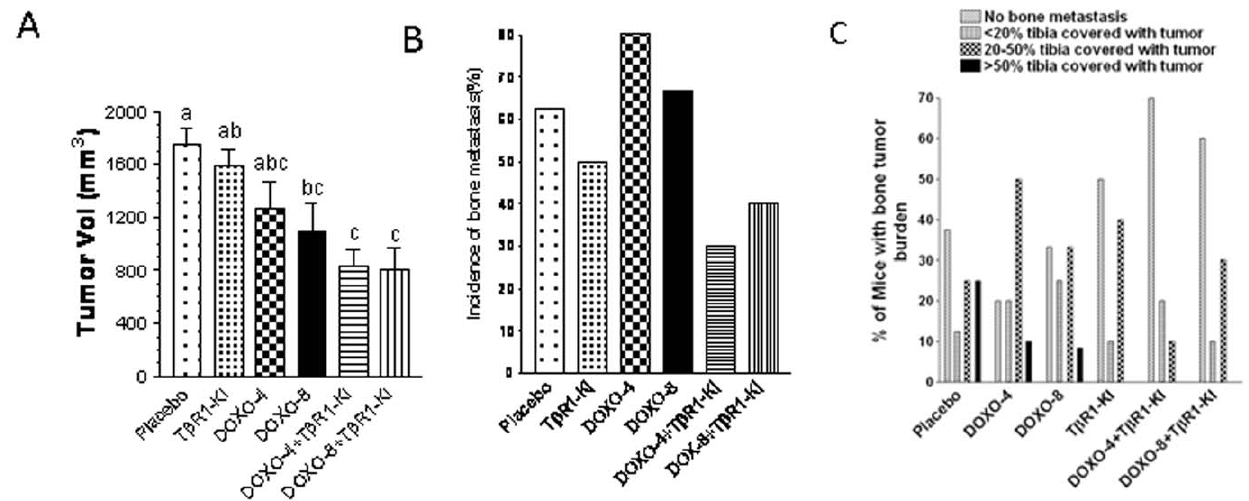
Figure 8. T b RI-KI reduced doxorubicin-induced spontaneous bone metastasis in the murine xenograft model. A. 4T1 cells (0.1 6 10 6 ) were inoculated into both inguinal mammary fat pads of syngeneic female balb/c mice. When the average tumor volume reached 60–70 mm 3 after 2 weeks, the mice were divided into six groups with similar tumor burden and treated i.p. with PBS (control), T b RI-KI at 1 mg/kg every alternative day, doxorubicin at 4 mg/kg (DOXO-4) or 8 mg/kg (DOXO-8) once per 7 days, or the combination of T b RI-KI and DOXO-4 or DOXO-8. The experiment was terminated after 3 wks of treatment and the final tumor volume (sum of two tumors per mouse) was used for calculating mean tumor volume 6 SEM from 6 mice in DOXO-8 and 5 mice in the rest groups. The bars bearing a different letter are significantly different (P , 0.05) by ANOVA. B. After the termination of the experiment, the leg bones (Femora and tibiae) were fixed in 10% neutral buffered formalin, decalcified in 10% EDTA and embedded in paraffin. Sections were stained with H&E, orange G and phloxine. The presence of tumors in the bone marrow was examined microscopically. The incidence of bone metastasis in each group of animals was expressed in percentage of the number of animals with bone metastasis. C. Animals with bone tumor burden were divided into four groups and the results were expressed in percentage of animals with no bone metastasis, with , 20% tibia replaced by tumor, with 20–50% tibia replaced by tumor, and with . 50% of tibia replaced by tumor.